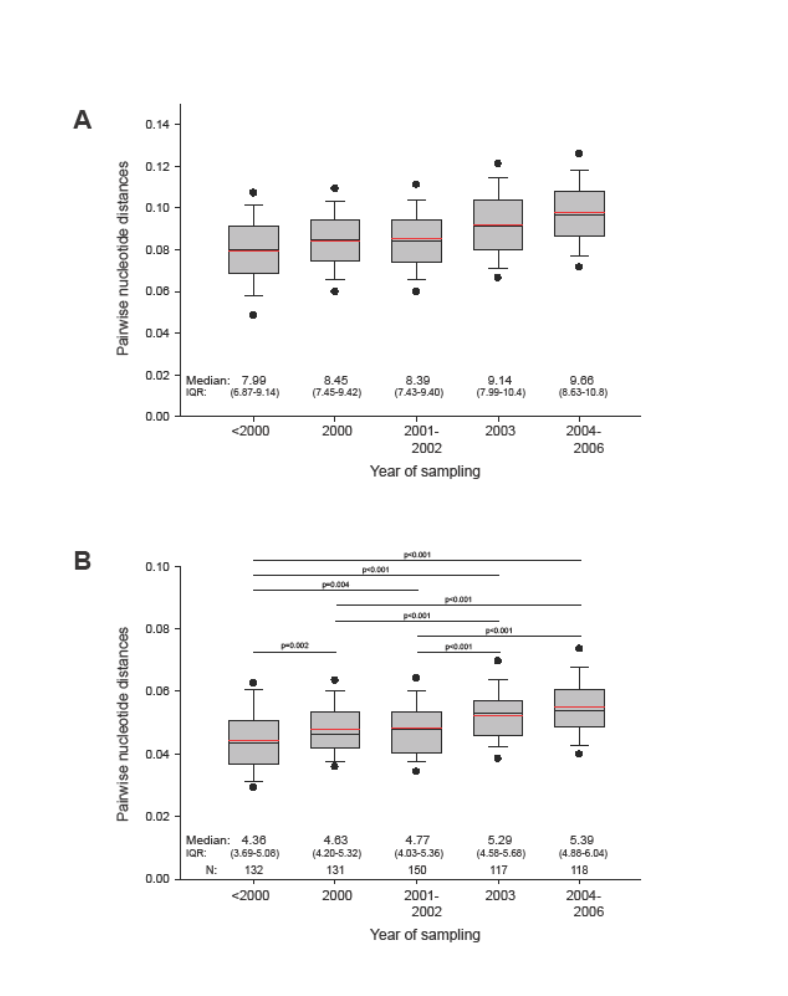
Figure 3. Pairwise distances of HIV-1 subtype C gag sequences collected at different time points. In the box plots: The boundary of the box closest to zero indicates the 25 th percentile, a black line within the box marks the median value, a red line within the box shows the mean, and the boundary of the box farthest from zero indicates the 75 th percentile. Whiskers above and below the box indicate the 10 th and 90 th percentiles. Points above and below the whiskers indicate the 5 th and 95 th percentiles. Five groups in each graph correspond to the time of sampling. A: Pairwise distances within group by sampling time. B: Pairwise distances to HIV-1 subtype C consensus. Comparisons between groups are based on Mann-Whitney sum rank